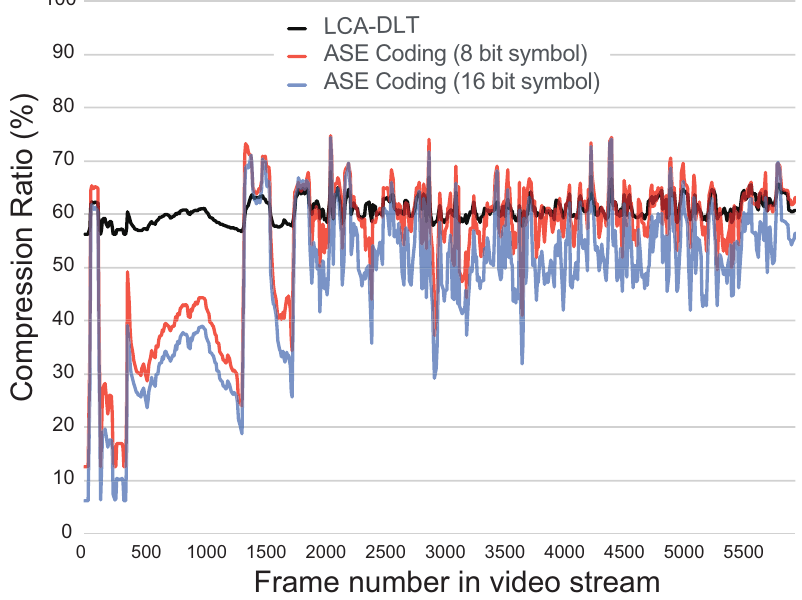
Figure 10. Realtime video compression